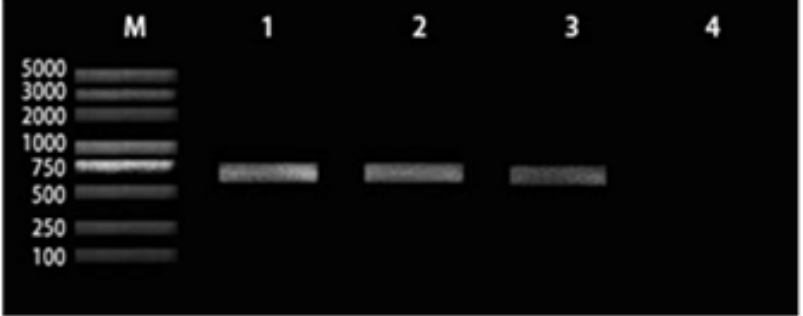
Figure 1. The amplification based on the wsp gene of Wolbachia . ‘M’ is DNA marker. The numbers of different lanes 1, 2, 3, and 4 denote the samples collected in Fenggang, Jiu’an, Meitan, and Pingtang respectively.